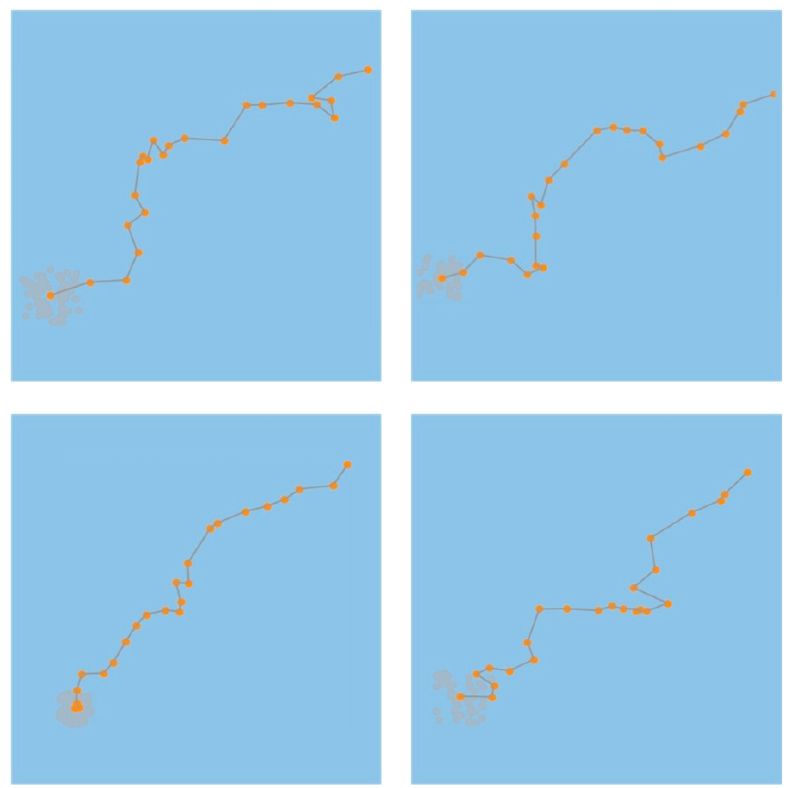
Figure 2. Four examples of average trajectory prediction over 24 h.